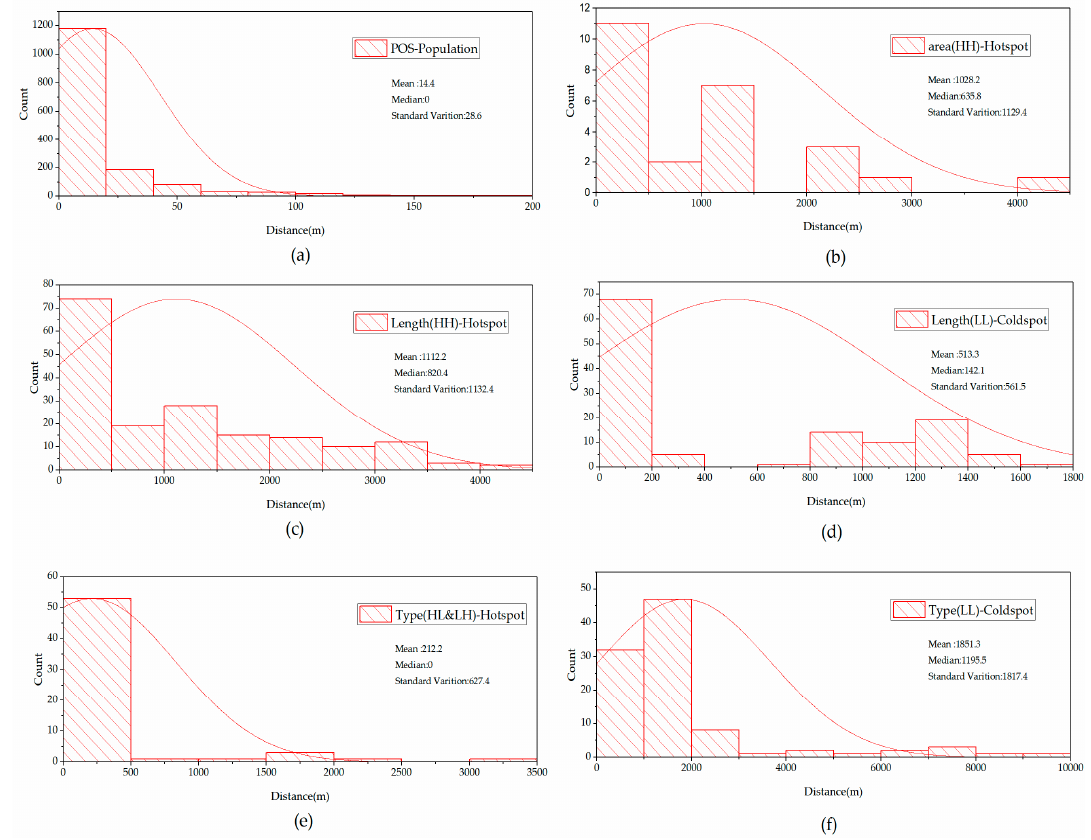
Figure 7. Statistic results of polygons distance between: ( a ) public open spaces and population; ( b ) area (HH) and hot spot; ( c ) length (HH) and hot spot; ( d ) length (LL) and cold spot; ( e ) type (HL and LH) and hot spot; ( f ) type (LL) and cold spot. * POS: Public Open